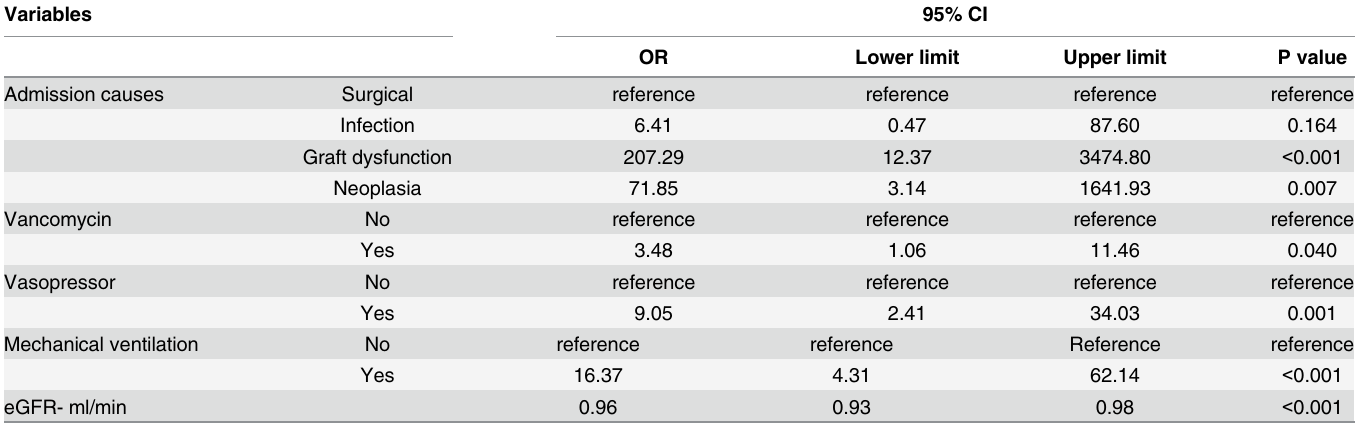
Table 3. Risk factors for severe AKI (use of renal replacement therapy): multivariate